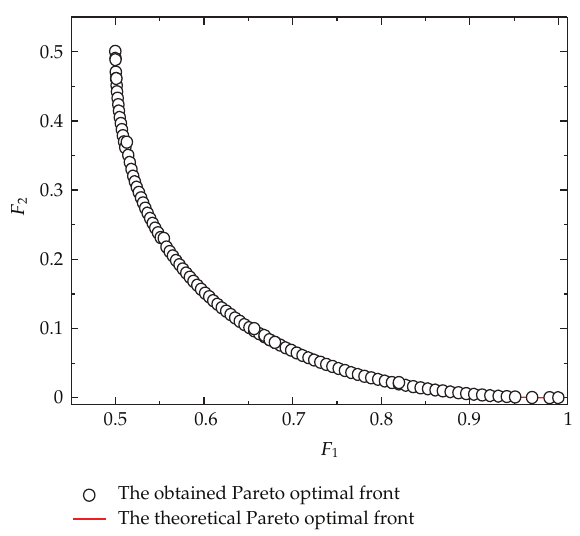
Figure 3: The obtained Pareto optimal front of Example 4.2.